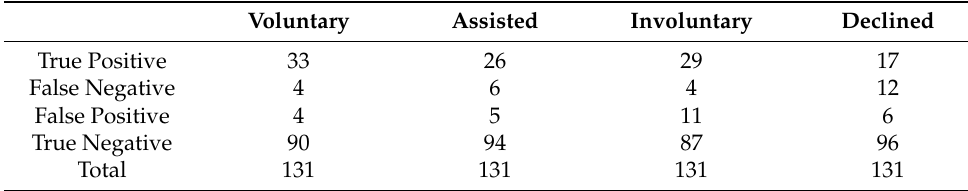
Table 3. True Positive, False Positive, True Negative and False Negative values 1